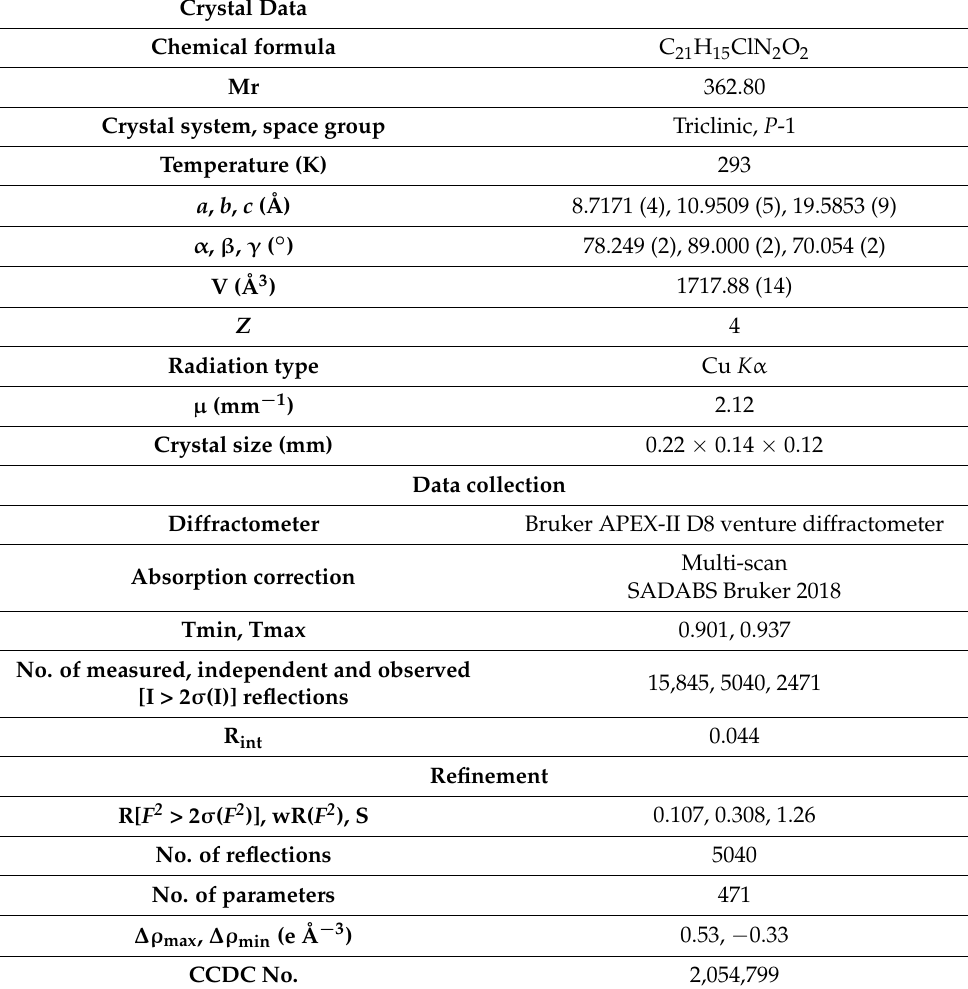
Table 1. X-ray experimental details for compound 4 .